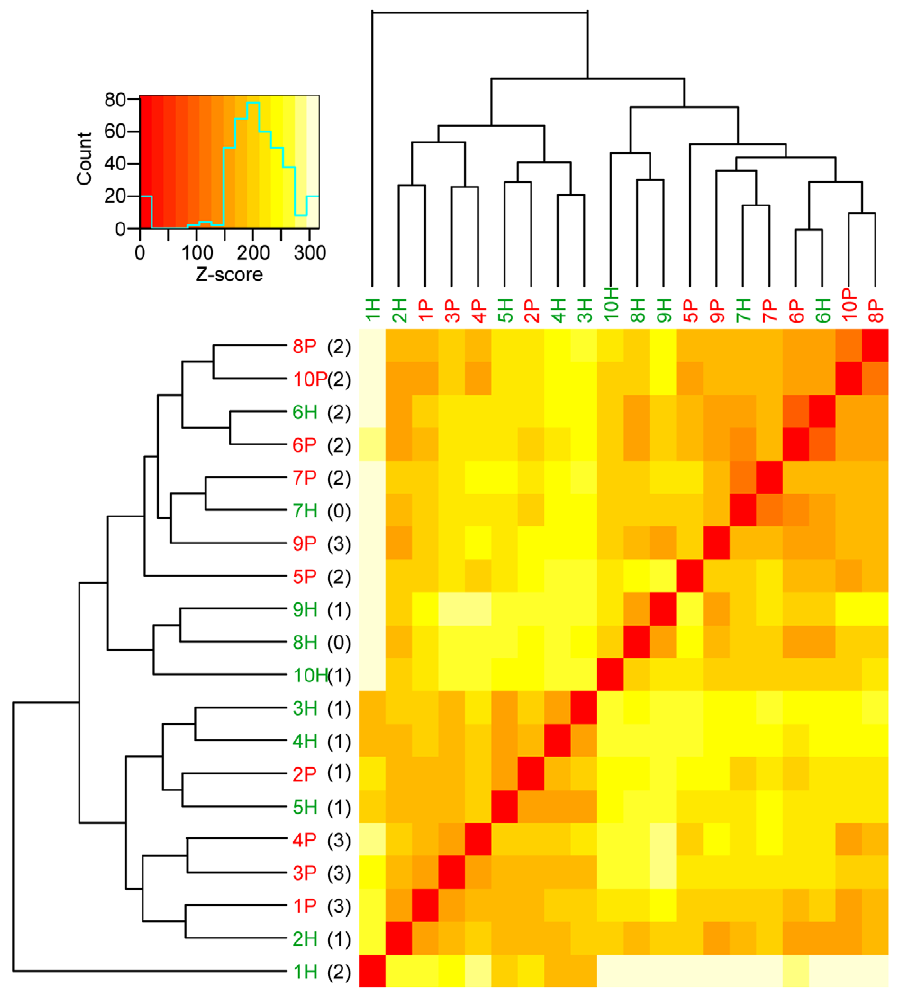
Figure 4. Clustering dendrogram and heatmap of periodontitis-affected and healthy biopsies. Clustering of all samples was based on gene transcripts with a median read above three times the background noise. The length of the branch between two biopsies and the colors of the heatmap correspond to degree of similarity between the gene expression profiles. Colors can be interpreted using the scale bar. Numbers in parentheses denote the inflammation scores of the biopsies after H&E histological evaluation.